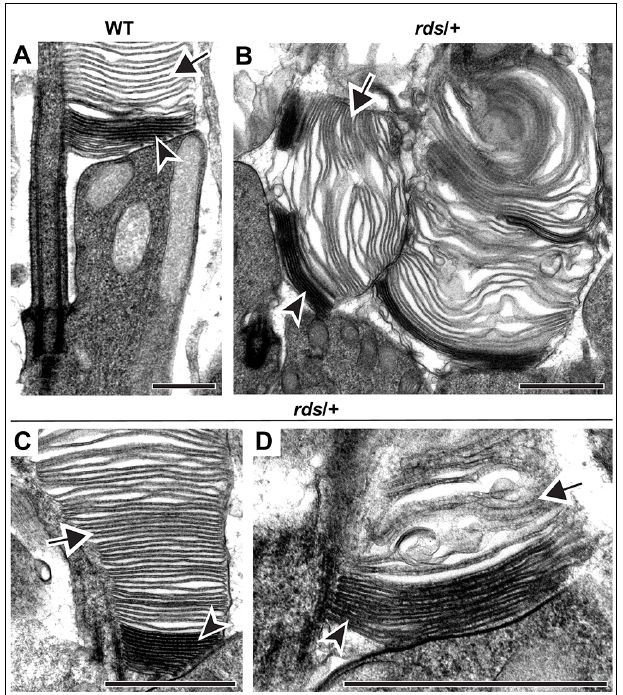
FIGURE 2 | Reduced expression of PRPH2 disrupts outer segment structure without preventing disc enclosure. Transmission electron microscopy (TEM) of photoreceptor outer segments from 12-day old WT (A) or rds /+ (B–D) mice stained with tannic acid. For each genotype, over 100 different outer segments from three mice were analyzed. For all images, arrowheads mark darkly stained open discs while arrows mark lightly stained enclosed discs. Scale bars are 1 µ m.